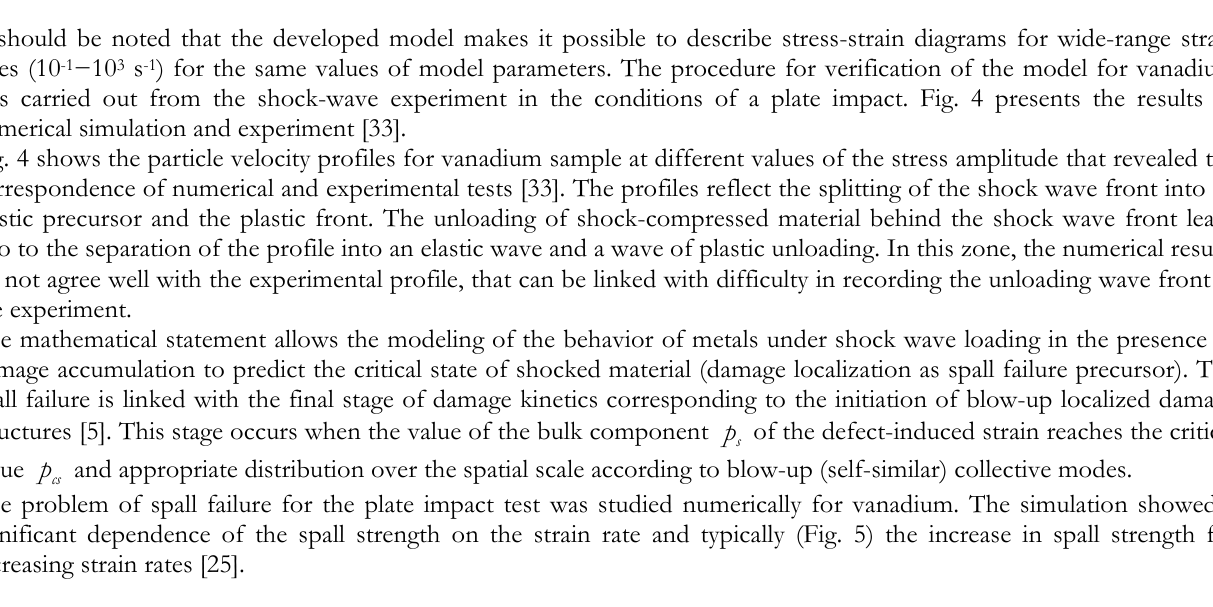
Figure 3: Experimental stress-strain diagrams for vanadium at different strain rates (dotted line − 10 -1 s -1 , dashed line − 10 3 s -1 ) and corresponded numerical simulation ( □ − 10 -1 s -1 , ○ − 10 3 s -1